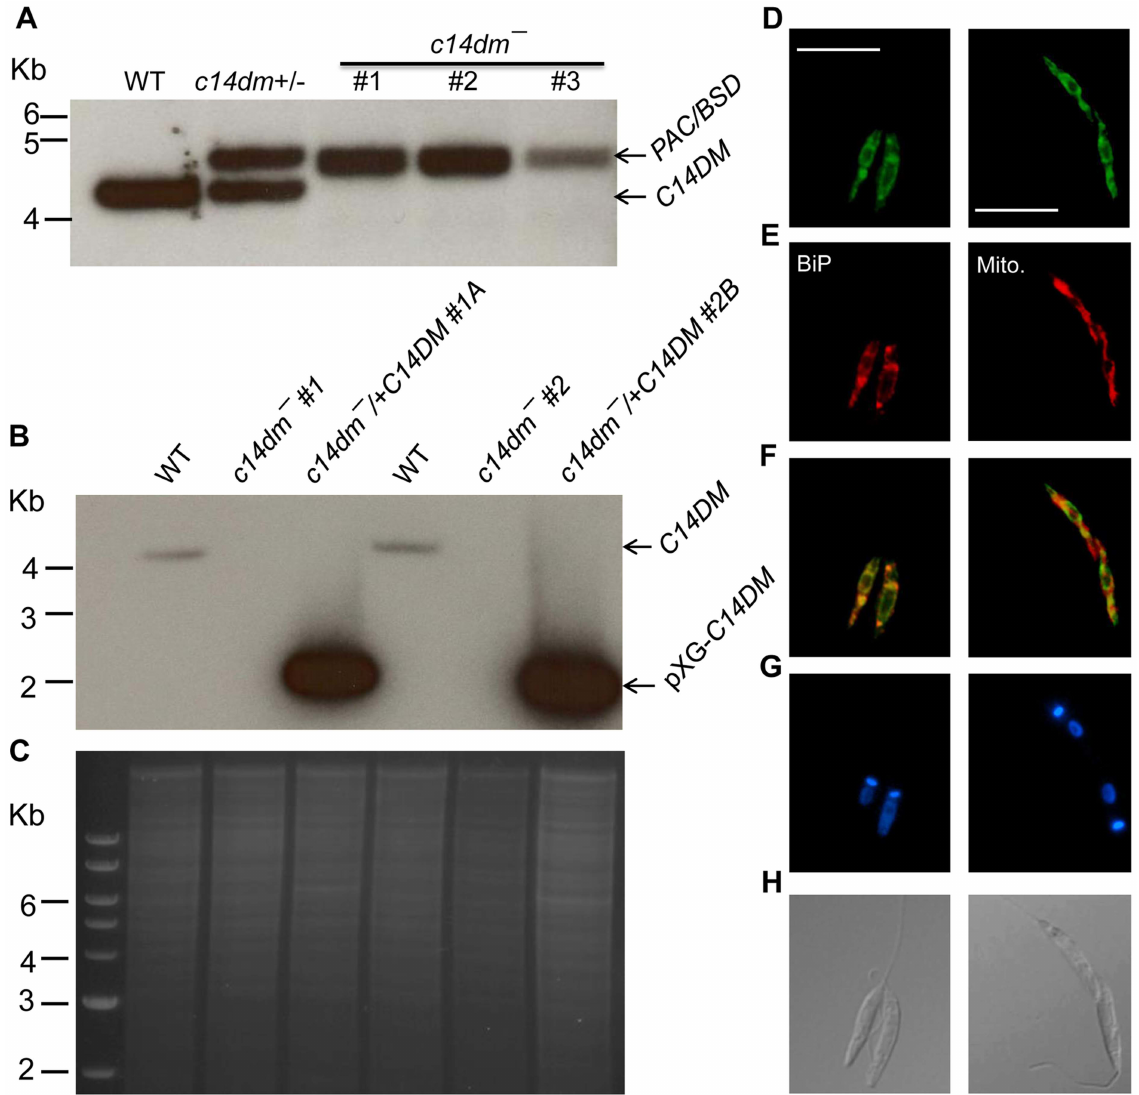
Figure 1. Targeted deletion and cellular localization of C14DM. ( A – C ) Genomic DNAs from L. major WT, c14dm + / 2 (heterozygous knockout), c14dm 2 (homozygous knockout) and c14dm 2 / + C14DM (episomal add-back) parasites were subjected to Southern blot analyses, using radioactive probes from an upstream flanking region ( A ) or the open reading frame ( B ) of C14DM . ( C ) DNA loading control for B (ethidium bromide staining). ( D – H ) Immunofluorescence microscopy of c14dm 2 / + C14DM-GFP promastigotes labeled with an ER marker (left panels) or Mitotracker (right panels). ( D ) GFP fluorescence (scale bars: 10 m m); ( E ) Anti-BiP staining (left panel; rabbit anti- T. brucei BiP antiserum followed by goat anti-rabbit IgG-Texas Red) or Mitotracker staining (right panel); ( F ) Merge of D and E ; ( G ) Hoechst staining of DNA; ( H ) Differential interference contrast (DIC)